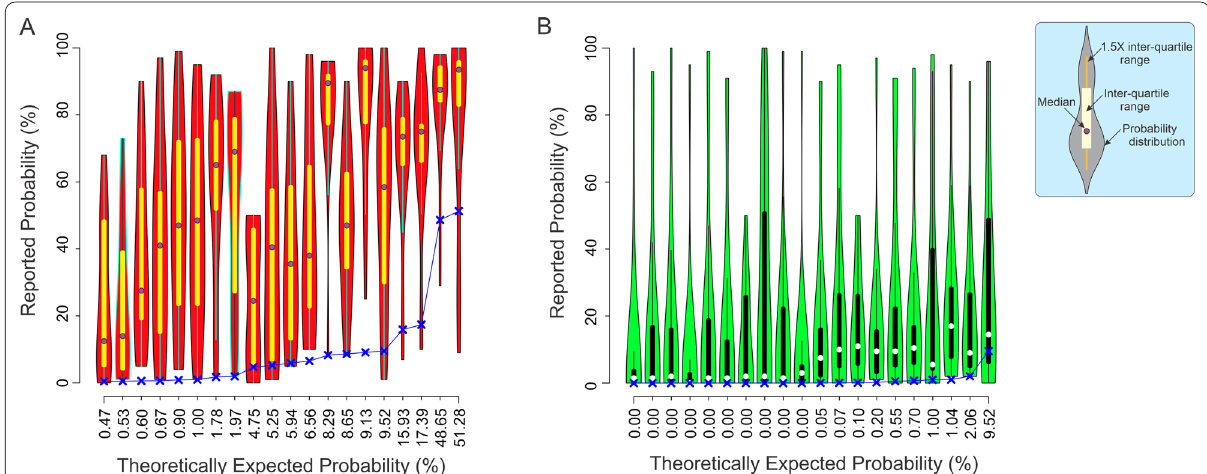
Fig. 1 Probability estimates reported by radiologists in Experiment 1. The estimated probability of cancer ( y -axis) in Experiment 1 plotted against the corresponding theoretically expected probabilities ( x -axis) as standard violin plots ((Thrun et al., 2020); also see inset at top right ). Conditions in which the CAD system determined the given mammogram to be positive or negative for cancer are plotted in ( A , B ), respectively. Each violin denotes one condition, i.e., one unique combination of the four probabilistic values provided to the subject. The blue X symbols and line graphically denote the theoretically expected probabilities (also see x-axis labels). See text for additional